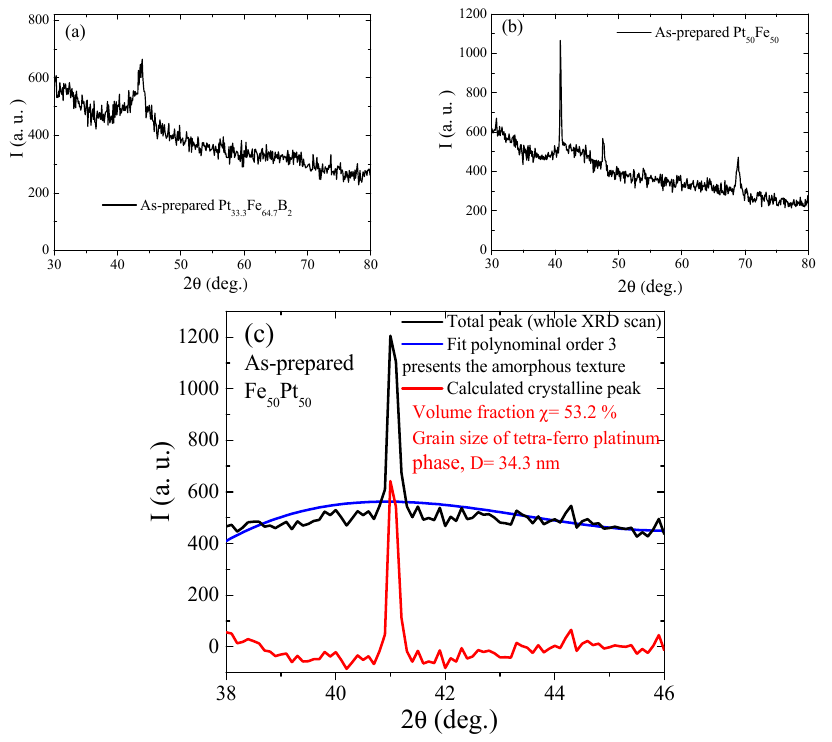
Figure 36. XRD of as-prepared Fe 33.3 Pt 64.7 B 2 ( a ), Fe 50 Pt 50 ( b ) microwires, and analysis of XRD spectra